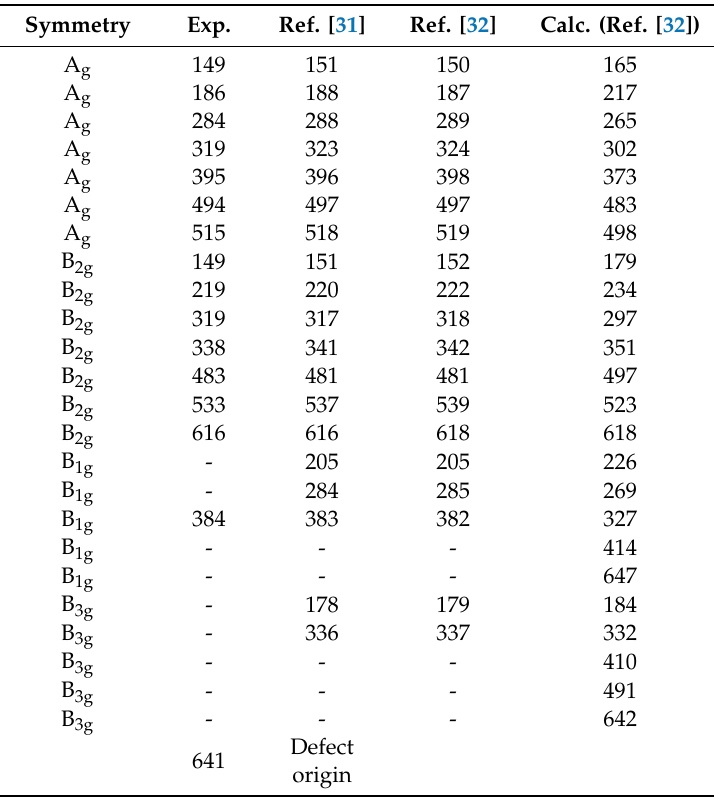
Table 3. Assignment of vibrational modes of YMnO 3 (in cm − 1 ) [31,32]. Symmetry Exp. Ref.